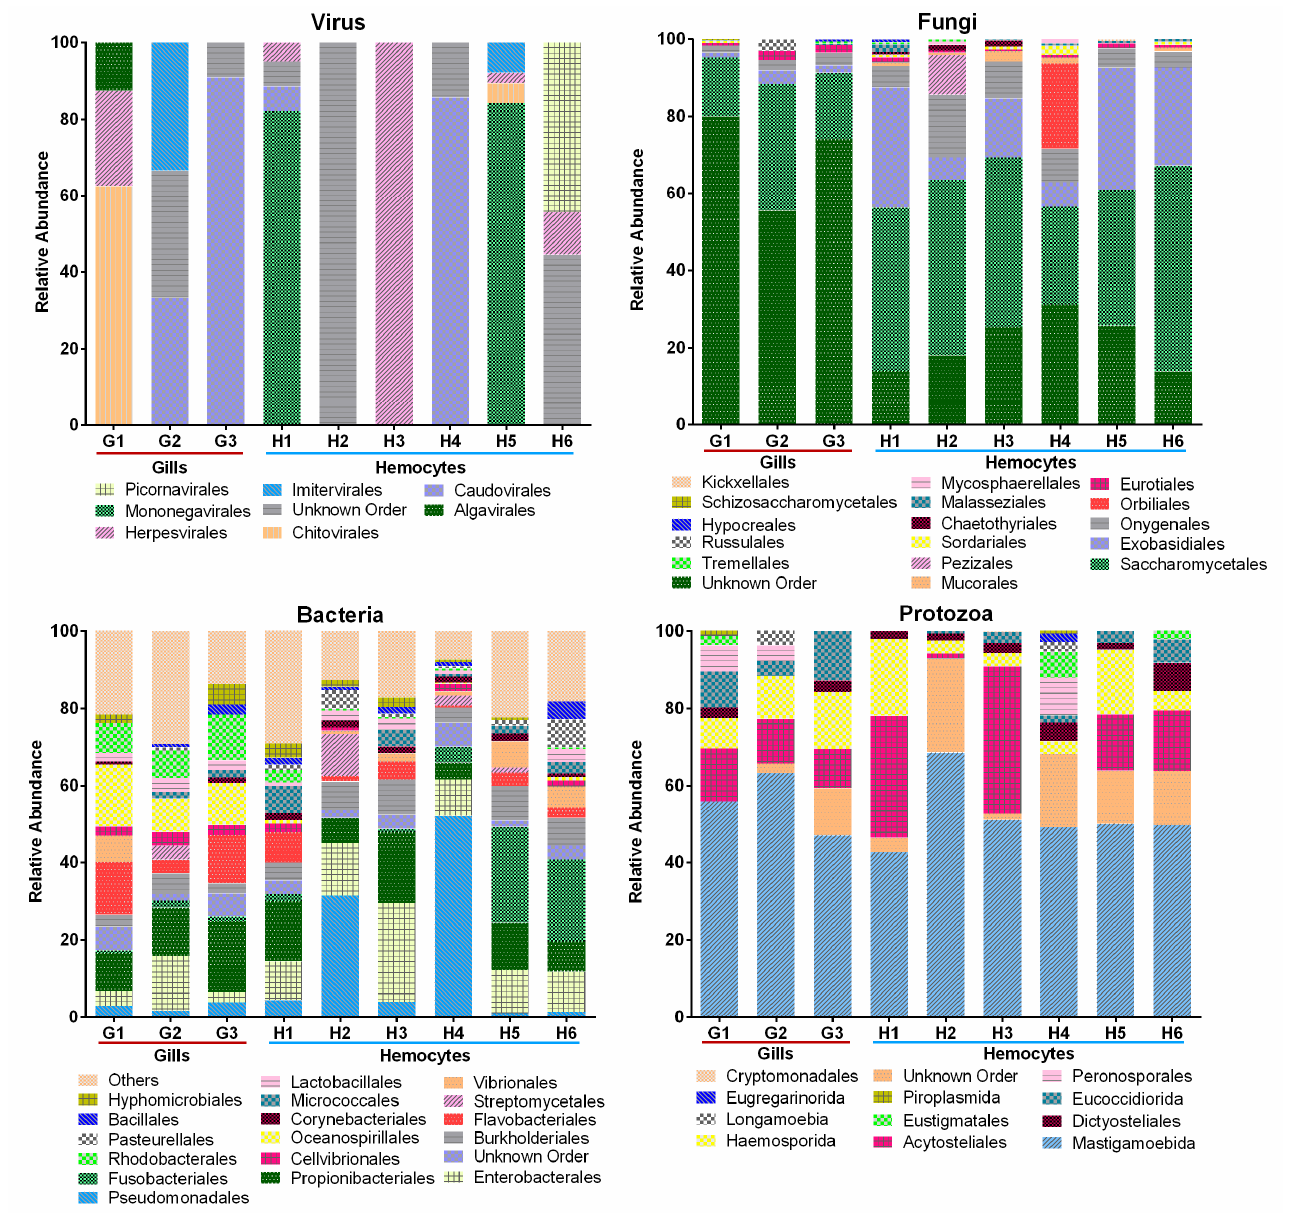
Figure 4. Taxa relative abundances in the gills and haemocytes of M. galloprovincialis . The taxonomic category shown is order.